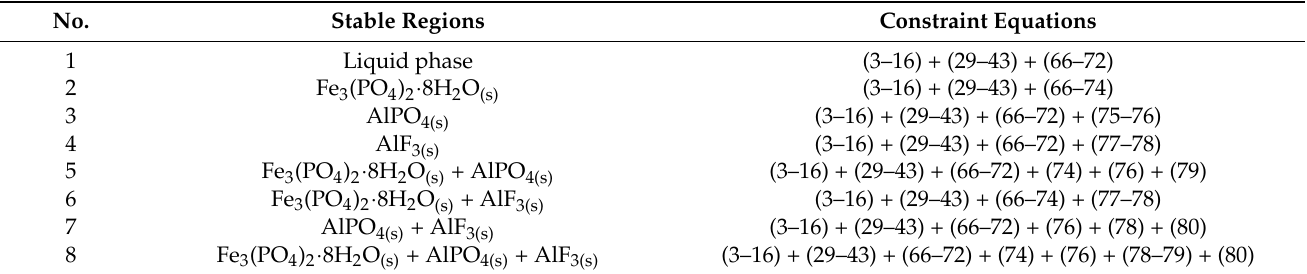
Table 6. Possible stable regions of Li + –Fe 2+ –Al 3+ –PO 43 − –SO 42 − –F − –H 2 O system and their corresponding constraint